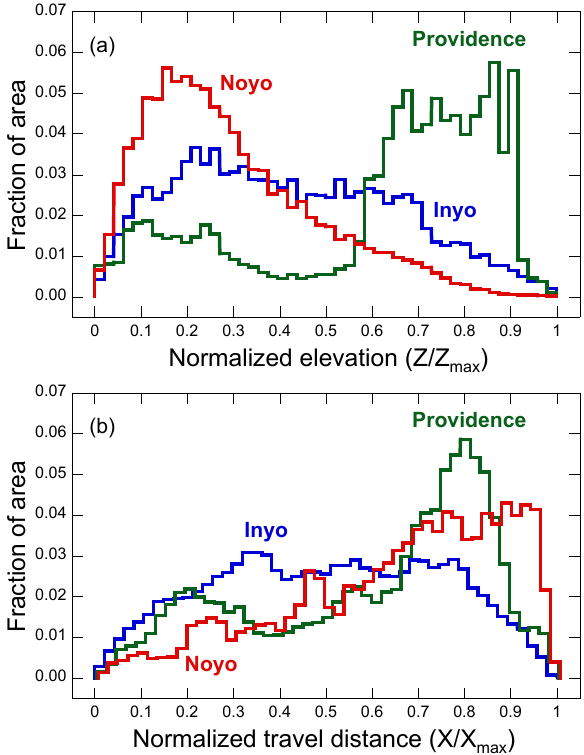
Figure 3. Hypsometry and width functions. Normalized frequency distributions of elevation (a) and travel distance to the outlet (b) . Frequencies are normalized so that the area under the curve is equal to 1 in each case. Binning increment is 1/47 of maximum value (Table